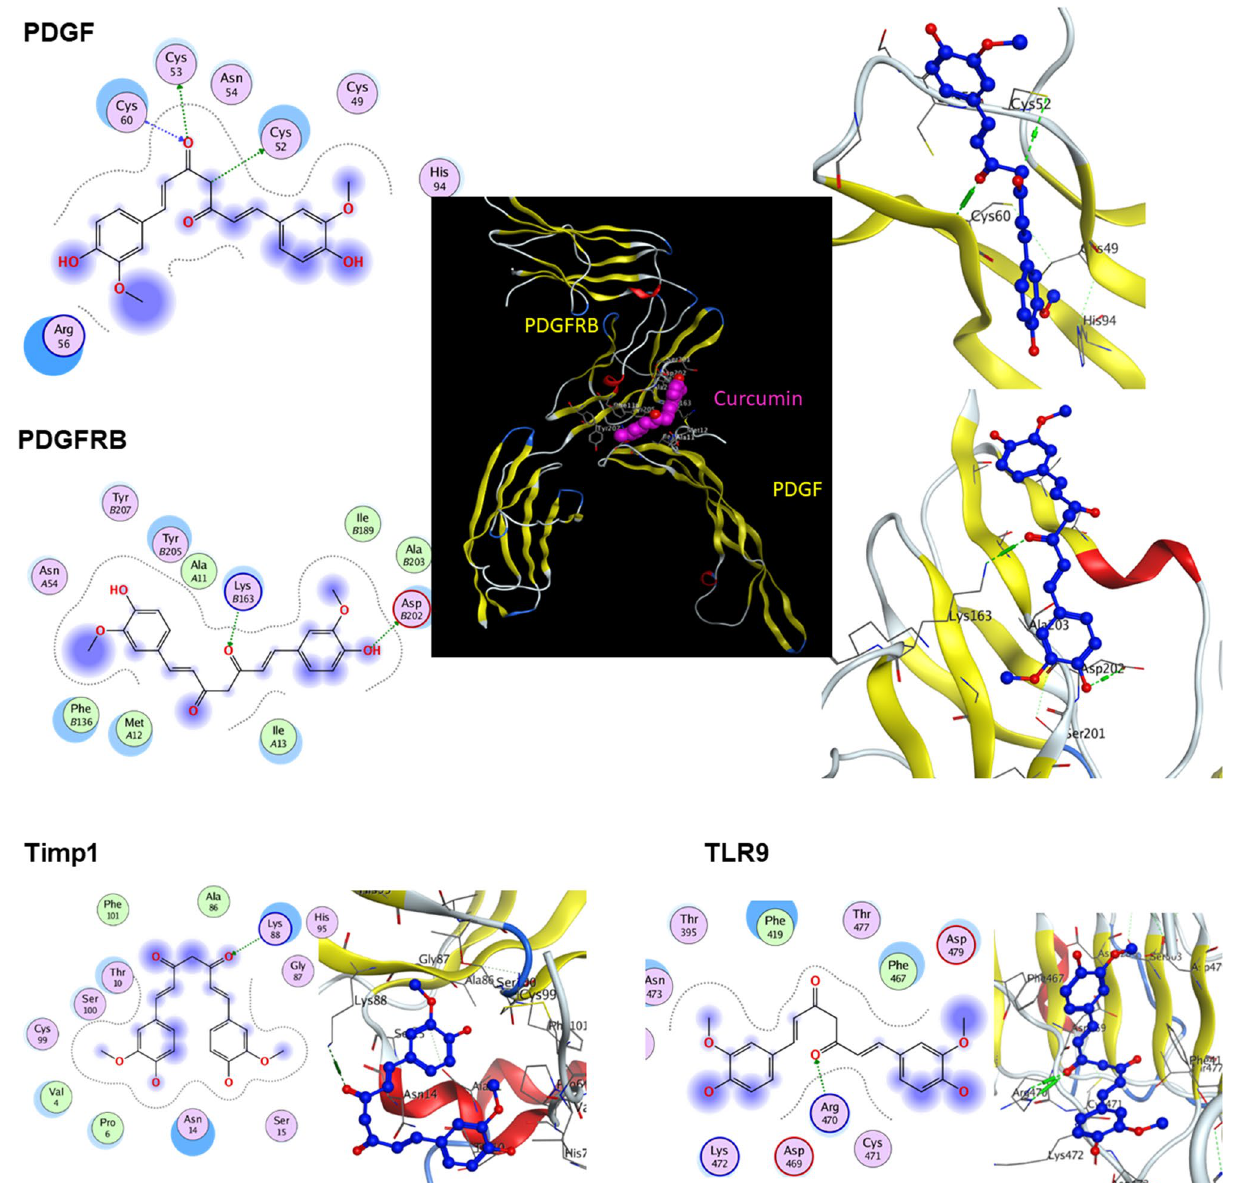
Figure 4. Molecular docking of curcumin in complex with different proteins involved in liver fibrogenesis. Left images are the structure and the 2D interaction between the curcumin and the receiving amino acid residues in the protein. Right images are the 3D docking position for curcumin (blue) binding with different proteins. Hydrogen bonds are presented in green. The middle black-backgrounded image is the 3D docking position for curcumin (magenta) binding with and positioned in the binding site between both PDGF and its receptor